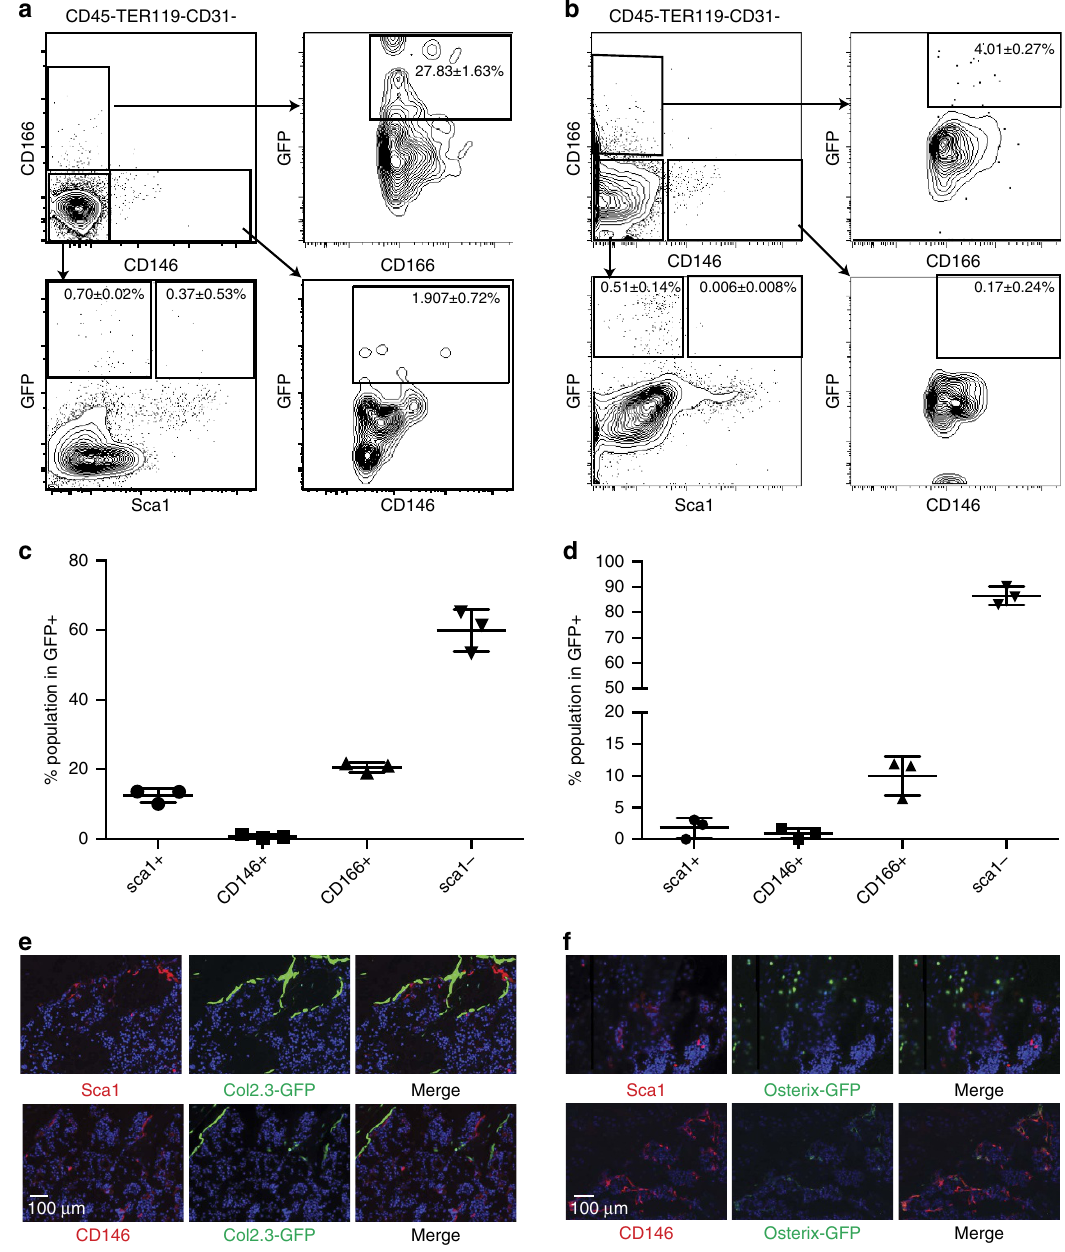
Figure 3 | CD 146 þ and CD 166 þ cells were marked by Col2.3-GFP or Osx1-Cre:GFP while Sca1 þ cells were not. ( a – b ) FACS analysis of bone- disassociated stromal cells (CD45 (cid:2) TER119 (cid:2) CD31 (cid:2) ) from ( a ) Col2.3-GFP or ( b ) Osx1-Cre:GFP mice. The fequency of the parent gate is displayed. ( c – d ) The frequency of Sca1 þ , CD146 þ , CD166 þ and Sca1- in the GFP þ population for (mean ± s.d.) ( c ) Col2.3-GFP and ( d ) Osx1-Cre:GFP obtained from FACS analysis ( n ¼ 3). ( e – f ) Sections of femurs from ( e ) Col2.3-GFP or ( f ) Osx1-Cre:GFP mice stained with antidodies to Sca1 or